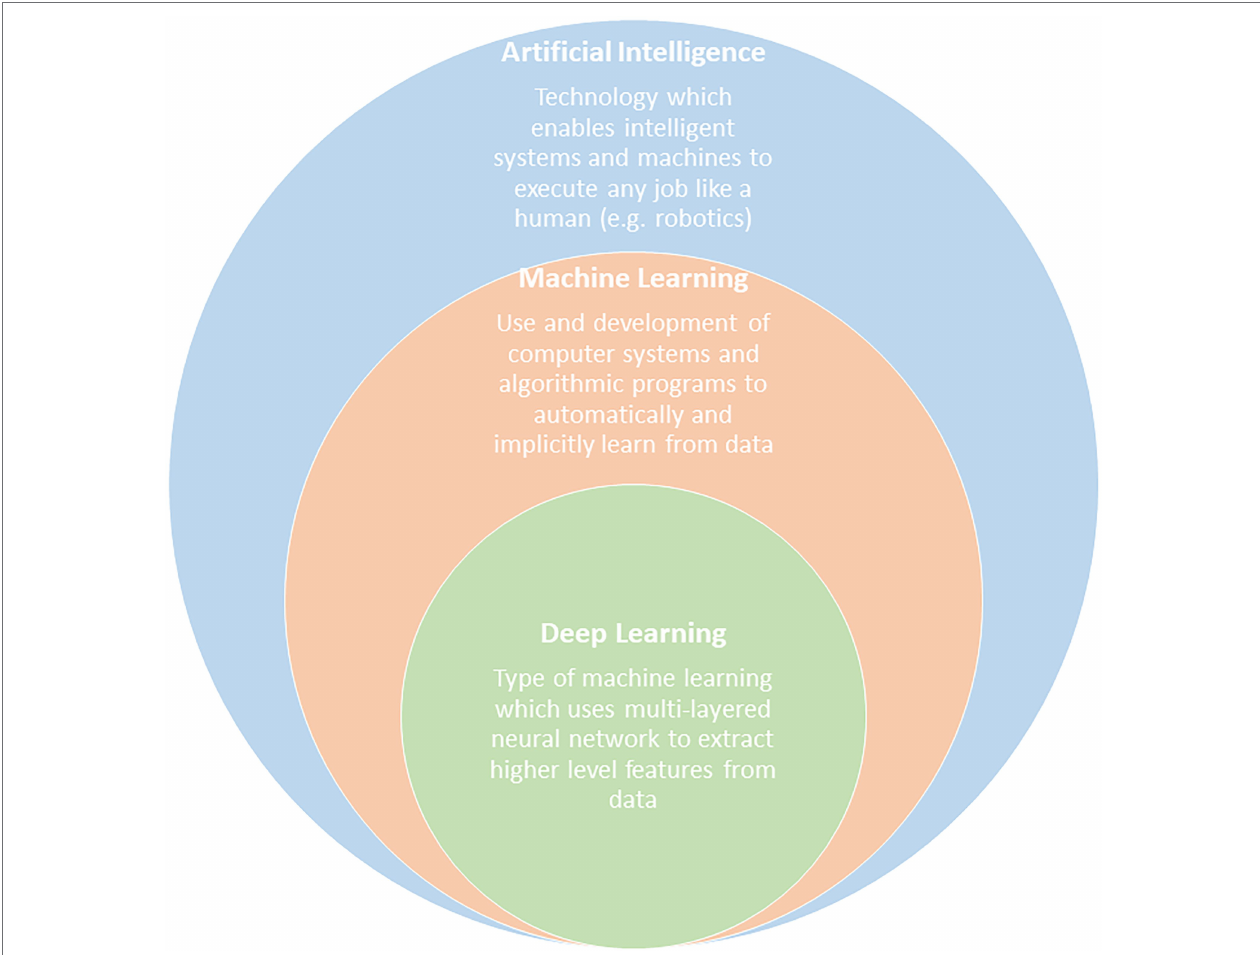
FIGURE 2 | The circle of learning in artificial